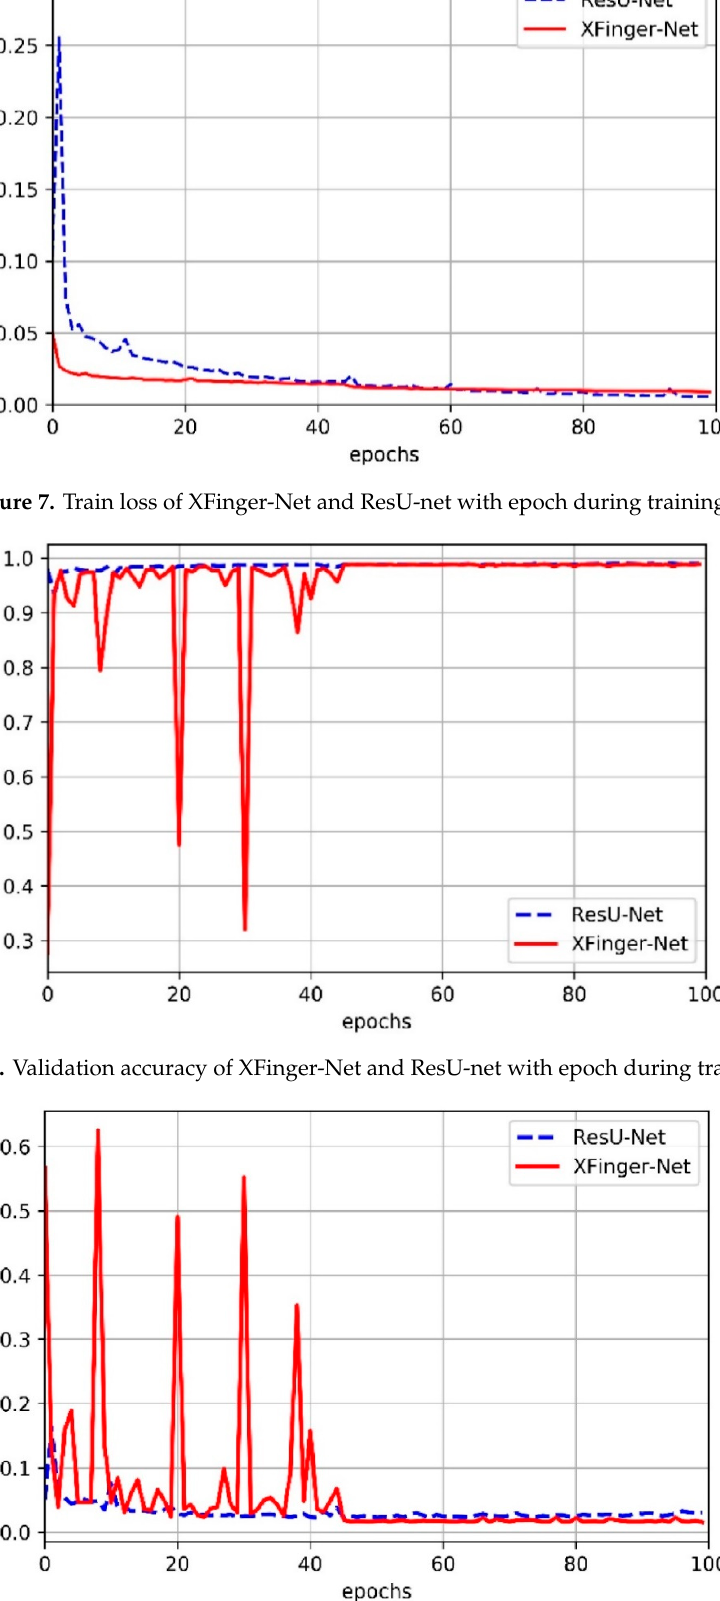
Figure 9. Validation loss of XFinger-Net and ResU-net with epoch during training.